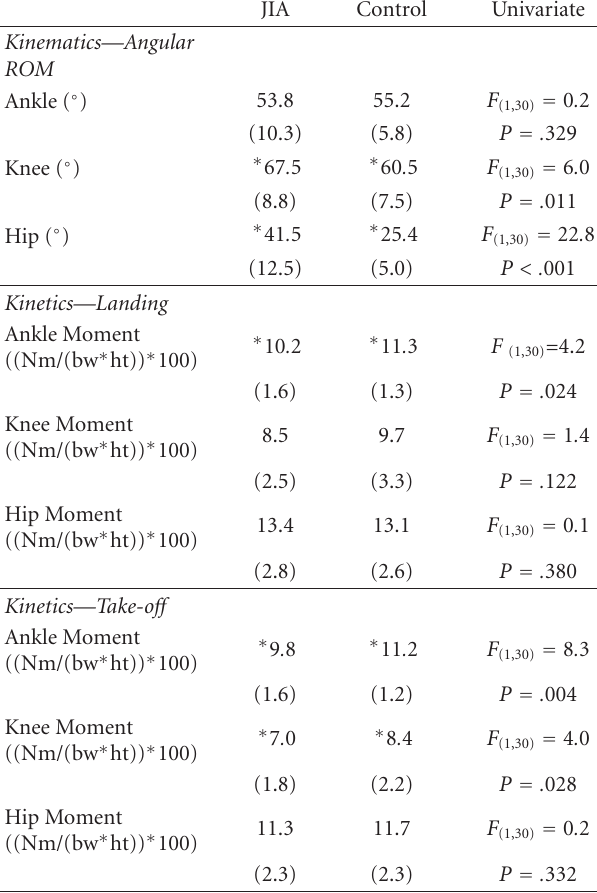
Table 1: Mean (SD) kinematic and kinetic variables for the involved sides of the JIA and Control groups. Multivariate analysis was significantly di ff erent between groups ( F (9,22) = 2 . 7, P = . 027). Univariate post-hoc analysis is listed for each variable ( ∗ P < .